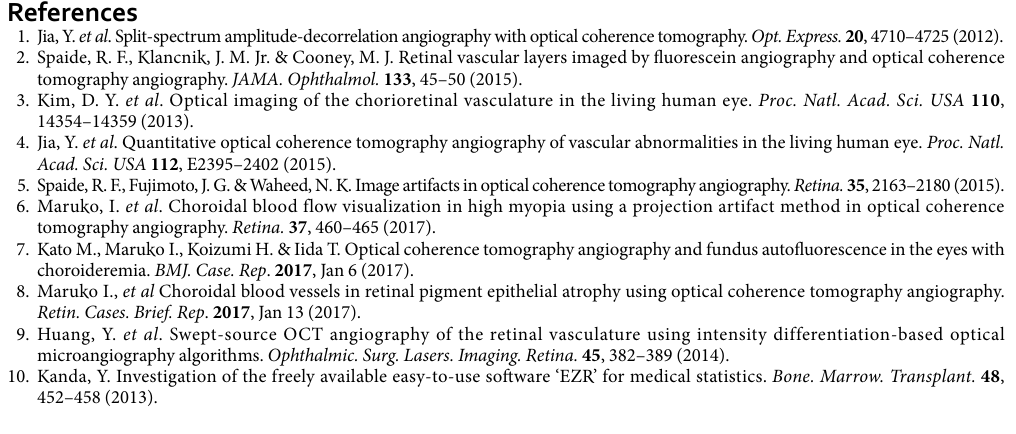
the ratio of choroidal blood flow area was calculated after the same binarization method. Because the images obtained by SD-OCTA would be within 3 × 3 mm, it was not necessary to eliminate the optic disc. Statistical analyses. All P -values were two-sided and P values < 0.05 were considered statically significant. All statistical analyses were performed with free software EZR (Saitama Medical Center, Jichi Medical University, Saitama, Japan), which is a graphical user interface for R (The R Foundation for Statistical Computing, Vienna, Austria) 10 . More exactly, it is a modified version of R commander designed to add statistical functions frequently used in biostatistics.